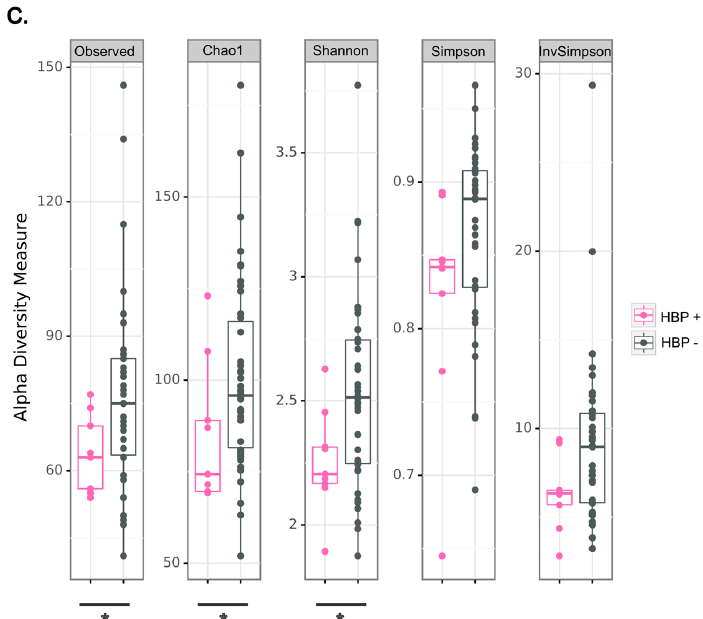
Figure 4. Microbiota profiles of high-diversity samples from granuloma split into the two groups: subjects with high blood pressure (HBP+) and without high blood pressure (HBP − ). ( A ) Granuloma microbiota composition at family level for high diversity split into the two groups, HBP+ and HBP − . Only the top 15 most abundant families are displayed; the remaining families are aggregated in the “other” category. ( B ) Linear discriminant analysis (LDA) effect size (LEfSe) cladogram of pairwise analysis for 16S rDNA sequence analysis of granuloma samples (the cladogram shows the taxonomic levels represented by rings with phyla at the innermost ring and genera at the outermost ring, and each circle is a member within that level) between the two groups, HBP+ and HBP − The histogram for relative abundance (%) for taxonomic groups identified by single letters in cladogram. (Data as mean ± SEM; * p < 0.05, ** p < 0.01, **** p < 0.0001, unpaired Mann–Whitney test and LDA score 2.0 for cladograms). ( C ) Alpha diversity analyses at OTU level confirm HBP+ and HBP − microbiome profiles in granuloma. Boxplots show the distribution of bacterial richness (observed OTUs and diversity (Shannon and Simpson) values of granuloma microbiota HBP+ and HBP − diversity profiles. Statistically significant differences were determined using a Wilcoxon test (* p < 0.05).